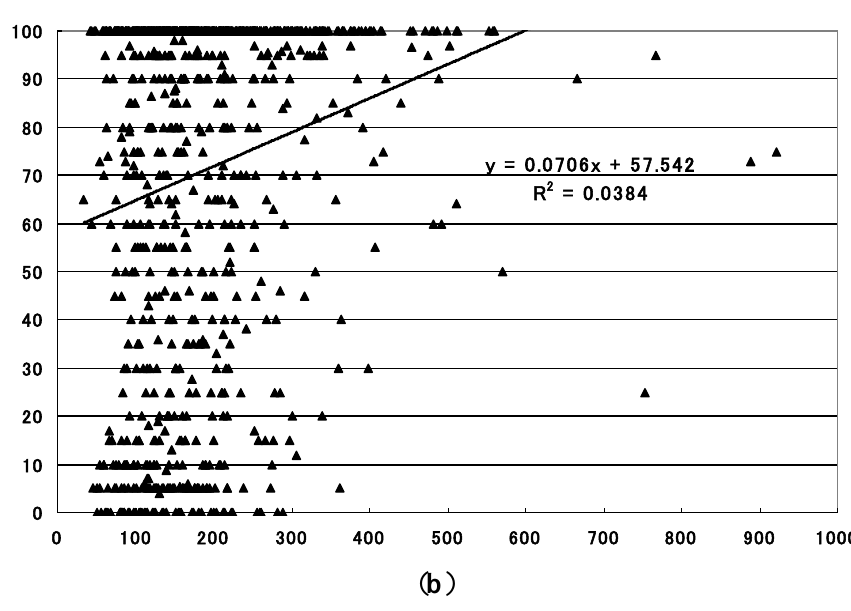
Figure 4. Relationship between summertime precipitation and sero-conversion rate to JE virus in sentinel pigs in the region 2 (central region). ( a ) Statistically significant inverse relationship with the mean sero-conversion rate ( p = 0.028). X-axis: precipitation during the period (mm), Y-axis: sero-conversion rate to JE virus (%); ( b ) Statistically significant inverse relationship with the maximum sero-conversion rate ( p = 0.012). X-axis: precipitation during the period (mm), Y-axis: sero-conversion rate to JE virus